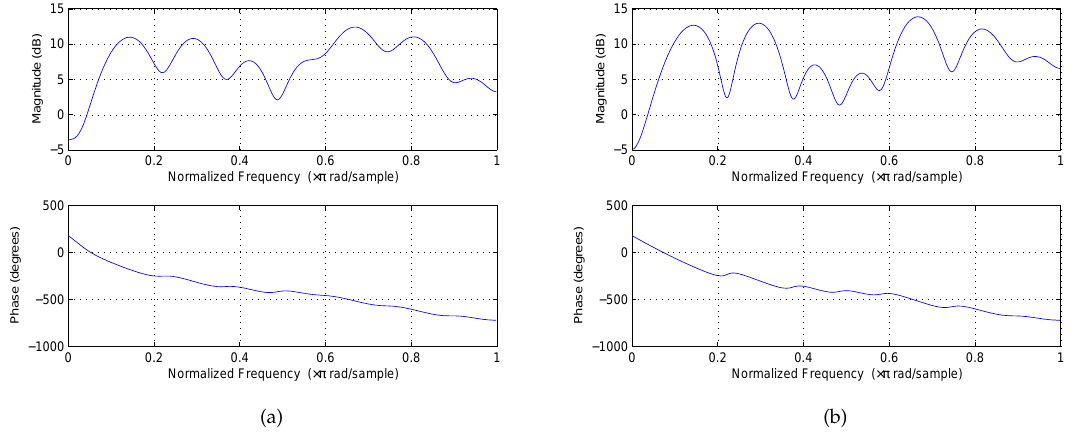
Figure 4. Frequency response of the acoustic paths S ( z ) . ( a ) Original acoustic path; ( b ) Changed acoustic path at n =